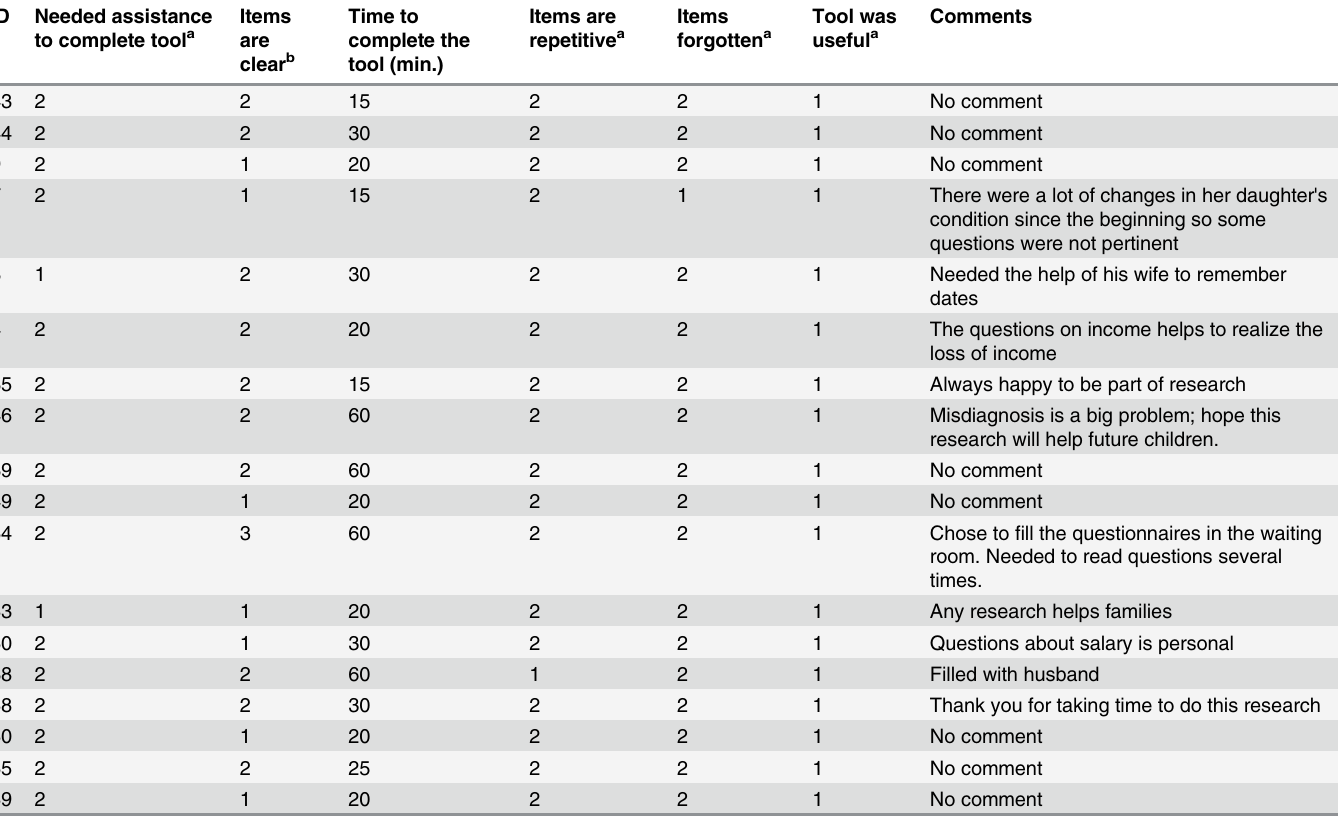
Table 4. Feedback from families on the questionnaire (n = 18) Items ID Needed assistance to complete tool a